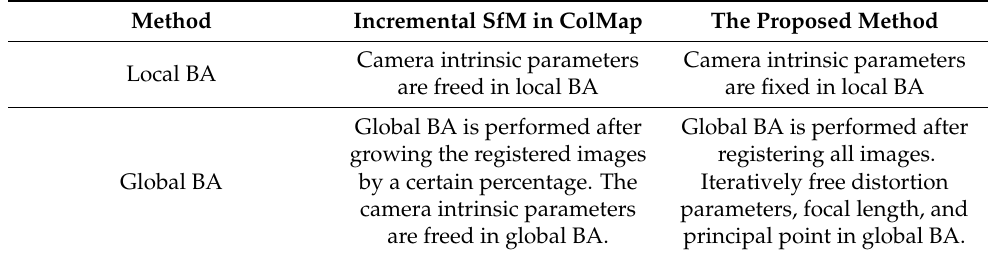
Table 1. The differences between the incremental SfM in ColMap [38] and the proposed method.